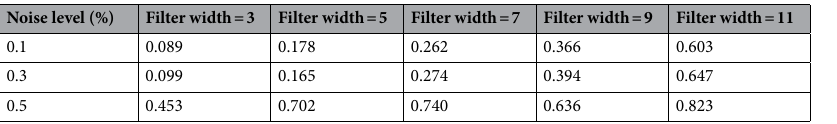
Table 1. Comparison of the RMSE values of each noise level image filtered using each filter size abwFMGFI.